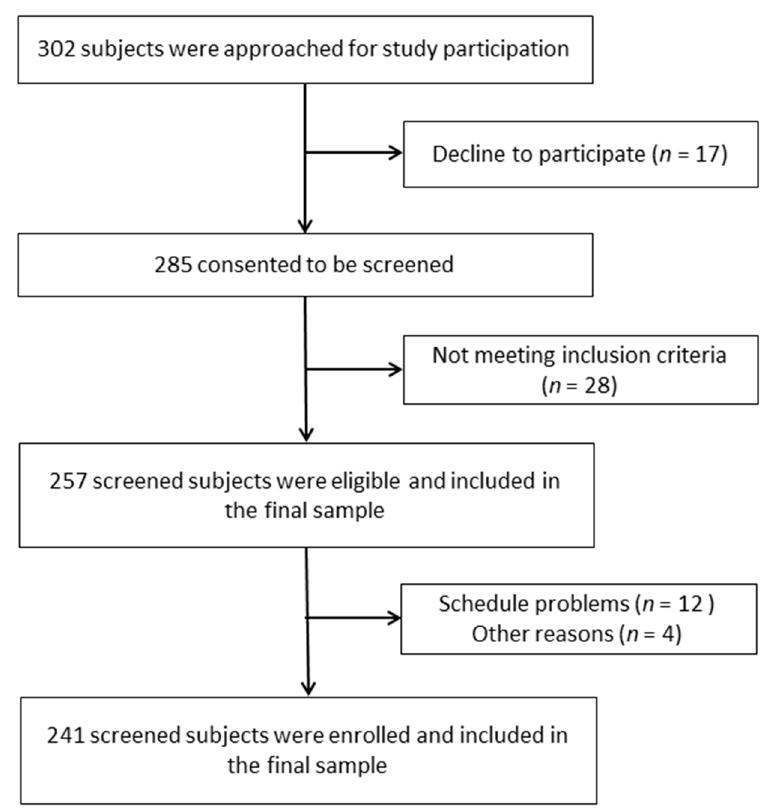
Figure 1. Flow chart of the study participants.